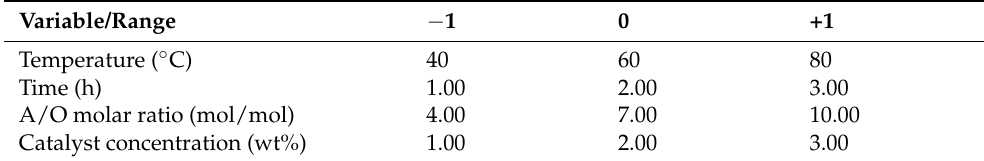
Table 1. The levels of parameters for biodiesel